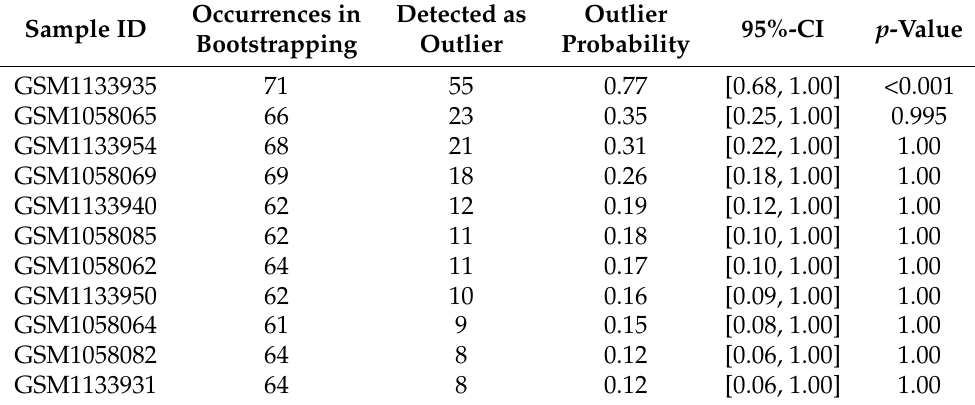
Table 3. Ten samples most frequently detected as outliers in the WNV dataset during bootstrap– bagplot analysis. The table includes sample ID, the number of occurrences in 100 bootstrap runs, and the number of bootstrap runs where the sample was detected as outlier. Additionally, the estimated outlier probability with a 95%-confidence interval and the p -value from the binomial test are